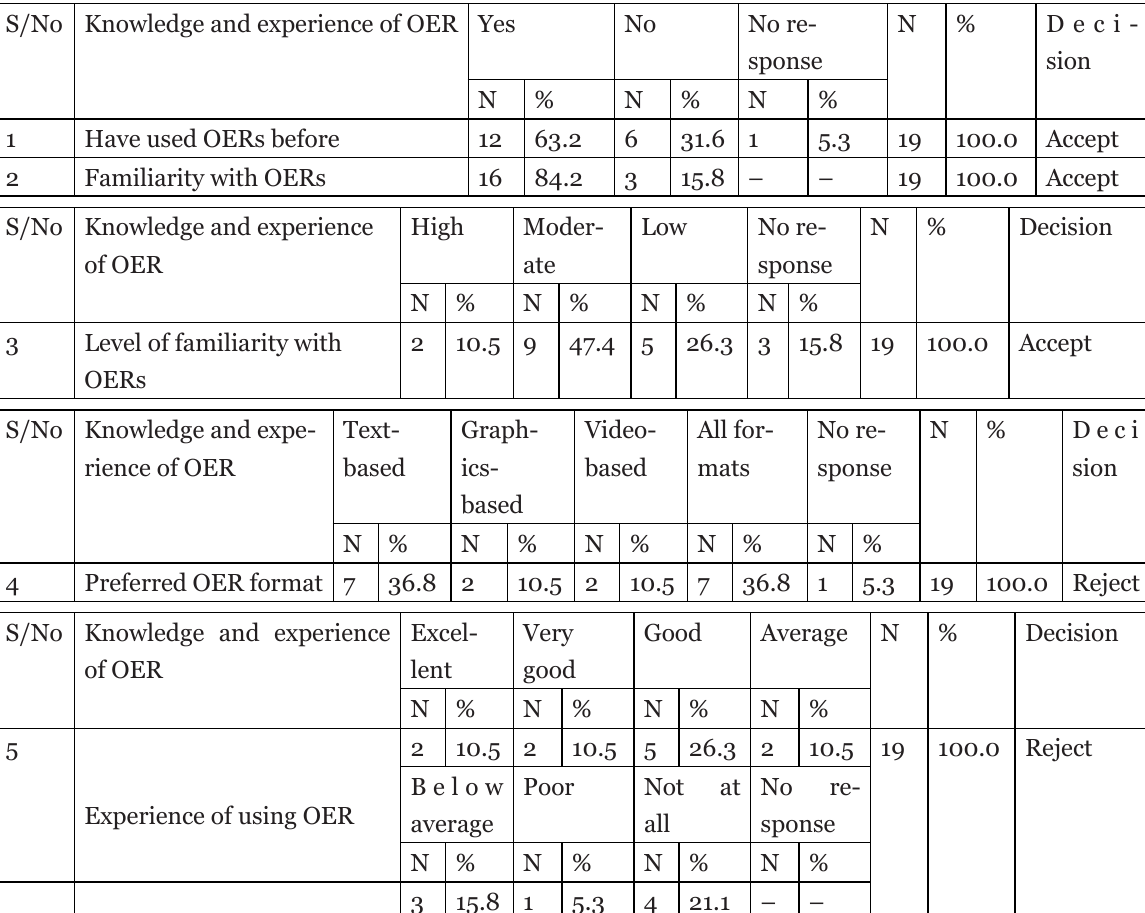
Table 1 Participants’ Knowledge and Experience of Open Educational Resources (OER) S/No Knowledge and experience of OER